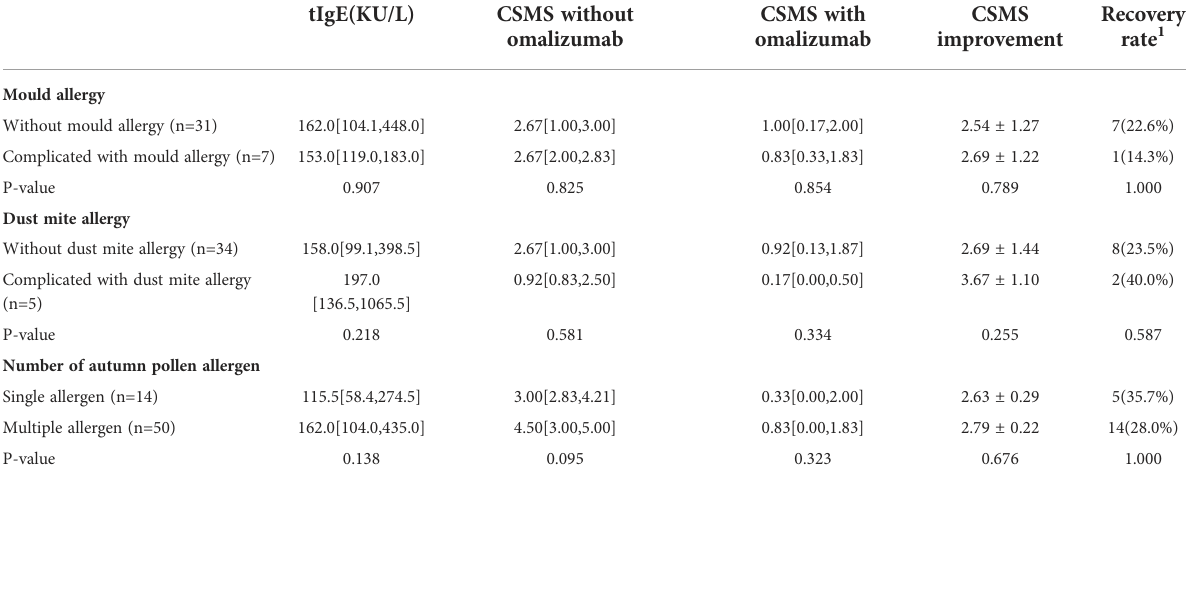
tIgE(KU/L) CSMS without